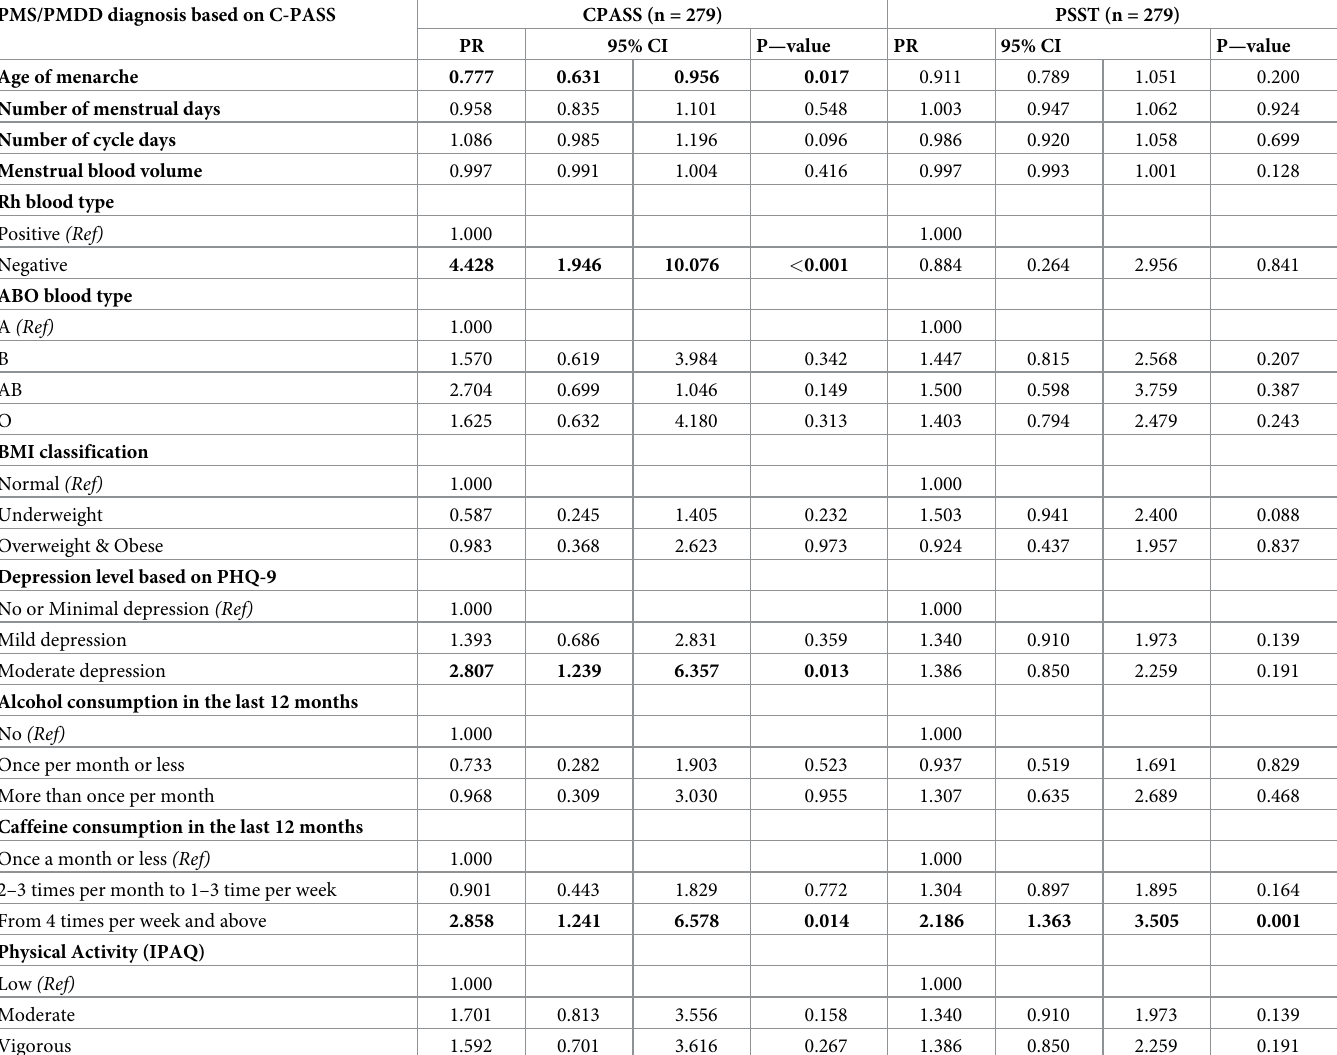
Table 4. Multivariable Poisson regression model of PMS/PMDD diagnosed by CPASS � and